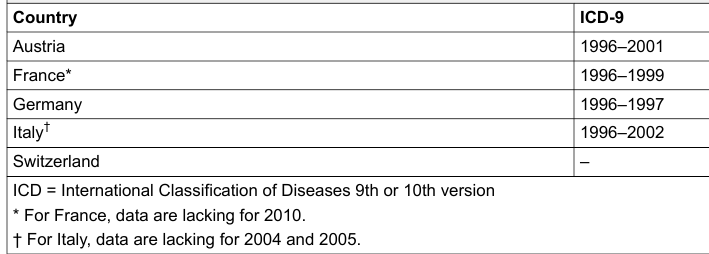
Table 1: Cause of death coding (ICD-version) by country and time period. Country